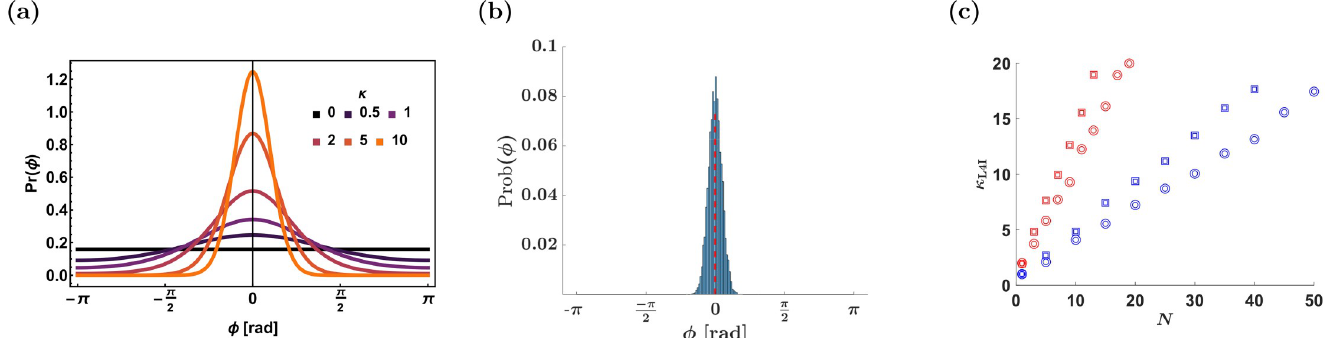
Fig 2. Distribution of preferred phases. (a) The von-Mises distribution, Eq (1), with ψ = 0 is shown for different values of κ as depicted by color. (b) The distribution of preferred phases in the uniform pooling model. The distribution was estimated from 10000 repetitions of drawing N = 100 neurons from the upstream population. The preferred phases in the upstream population were drawn in an i.i.d. manner following Eq (1), with κ UpStream = 1 and ψ UpStream = 0. The dashed red line depicts the mean phase. (c) Distribution width in the naive uniform/random pooling model. The width of the distribution of preferred phases, κ L4I , in the downstream layer (L4I) is shown as a function of the number of pooled VPM neurons, N , for the uniform and random pooling in squares and circles, respectively. The width of the distribution, κ L4I , was estimated from 10000 repetitions of drawing N preferred phases of the upstream population with κ = 1 (blue) and κ = 2 (red).